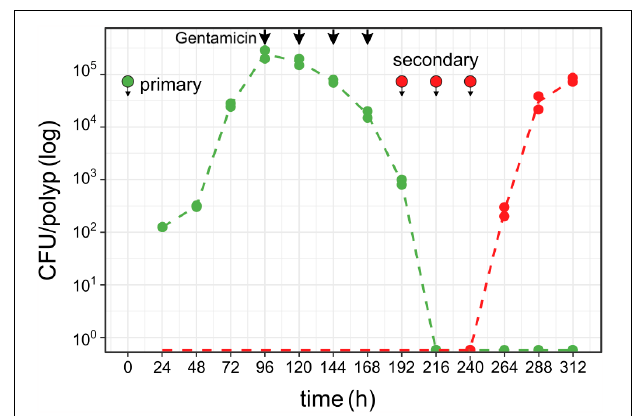
FIGURE 4 | Colonizer population disturbance and re-colonization on Hydra . Curvibacter population size of first (green, pRL153-GFP) and second [red, attTn7::miniTn7(aacC1) ] colonizer populations on Hydra ( n = 2; dashed line represents the mean population size) during colonization and after colonization disruption by antibiotic treatment (black arrows, see section “Results” for details). Symbols indicate the time points of infection with Curvibacter